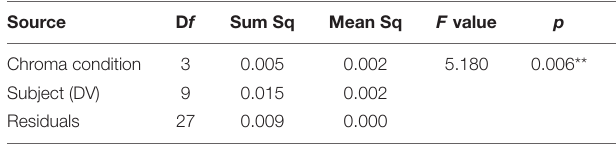
TABLE 2 | ANOVA results of psychophysical